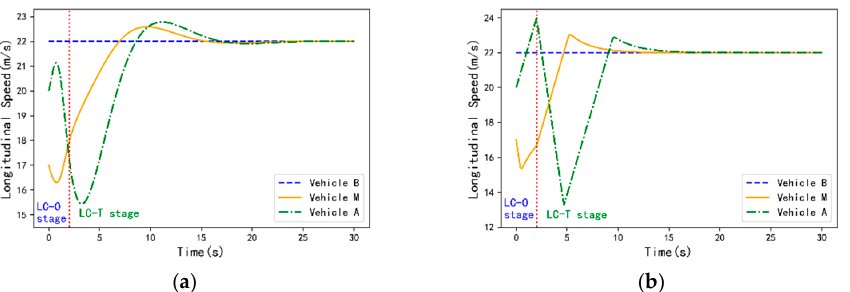
Figure 6. The longitudinal positions of vehicles B, M, and A of the two control strategies in scenario 1. ( a ) The proposed CLC control strategy, ( b ) CACC_Sine control strategy.